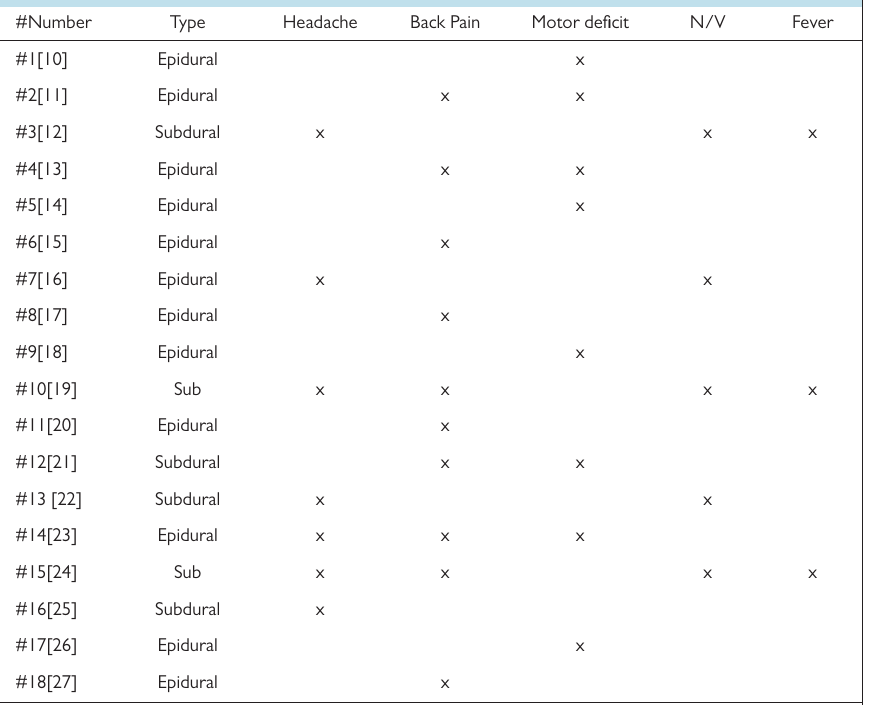
Table 3. Types of hematomas and associated symptoms